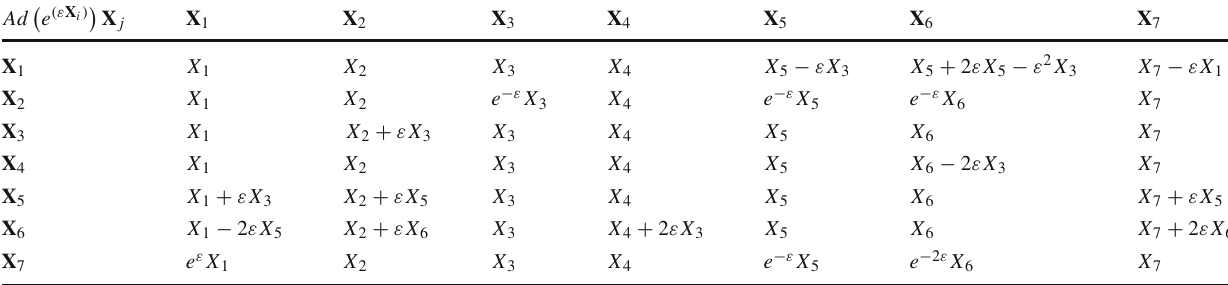
Table 2 Adjoint representation for the admitted Lie point symmetries for the Karmarkar condition (26) (cid:14) (cid:15) Ad e (ε X i ) X